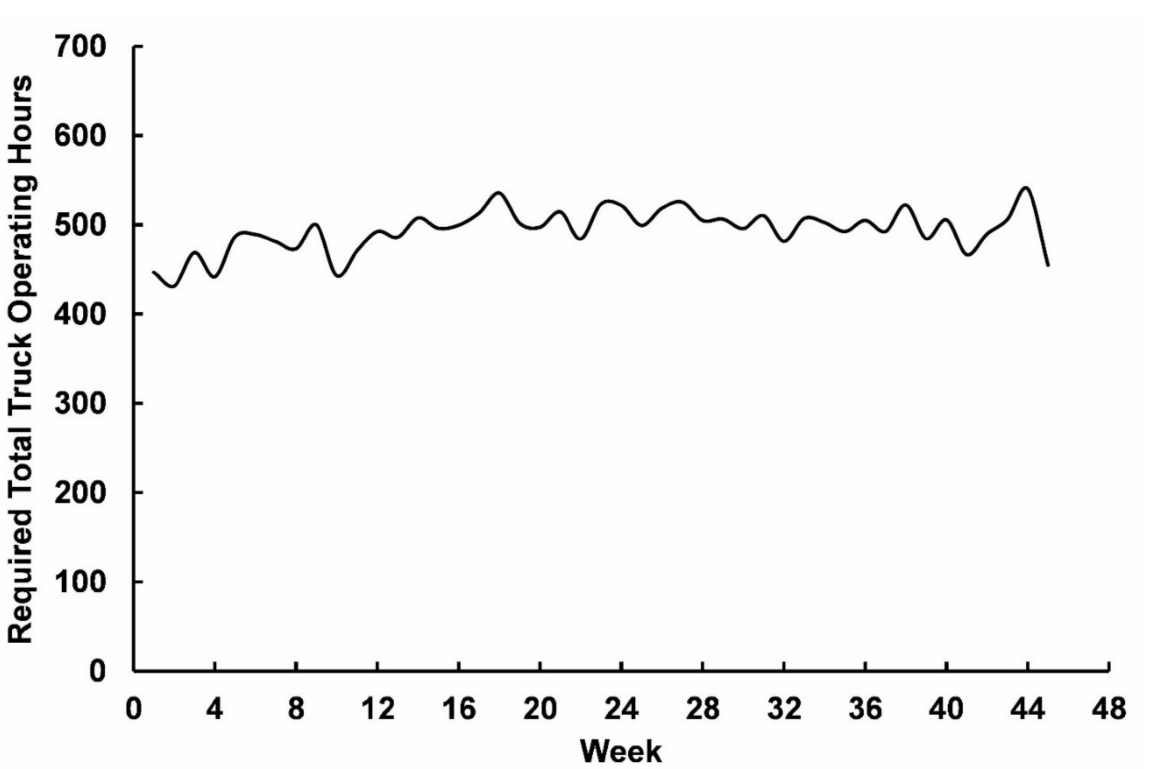
Figure 9. Required weekly truck fleet operating hours over the 47-week season of the 10-load-out